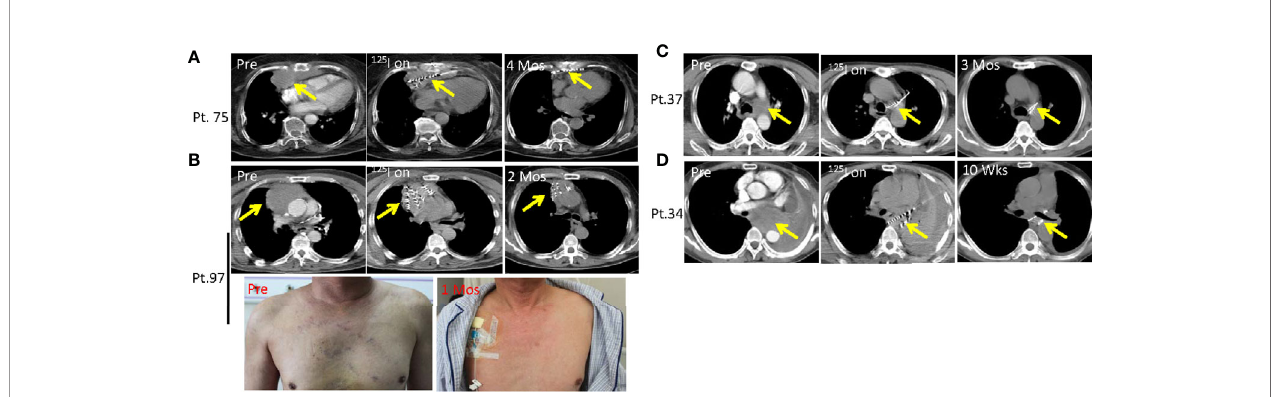
FIGURE 6 | Dysphagia, arrhythmia and superior vena cava syndrome due to compression of mediastinal and lung tumors is alleviated by SNCP- 125 I brachytherapy. (A) Patient 75 was an 84 years old patient with malignant aggressive thymoma and progressed on surgery and radiotherapy. The tumor signi fi cantly regressed after SNCP- 125 I brachytherapy treatment in 4 months. (B) Patient 97 was diagnosed as malignant aggressive thymoma, experienced compression of the superior vena cava causing super fi cial venous dilation of the chest wall. Following SNCP- 125 I brachytherapy, the tumor signi fi cantly regressed in 2 months and superior vena cava syndrome was alleviated in 1 month. (C) Patient 37 with a lung tumor repressing the laryngeal nerve, invading both pulmonary artery and trachea. The tumor shrunk in 3 months via SNCP- 125 I brachytherapy. (D) Patient 34 was diagnosed as mediastinal lung cancer with the tumor compressing the esophagus and causing dysphagia. The dysphagia symptom disappeared through SNCP- 125 I treatment within a month followed by tumor regression. Yellow